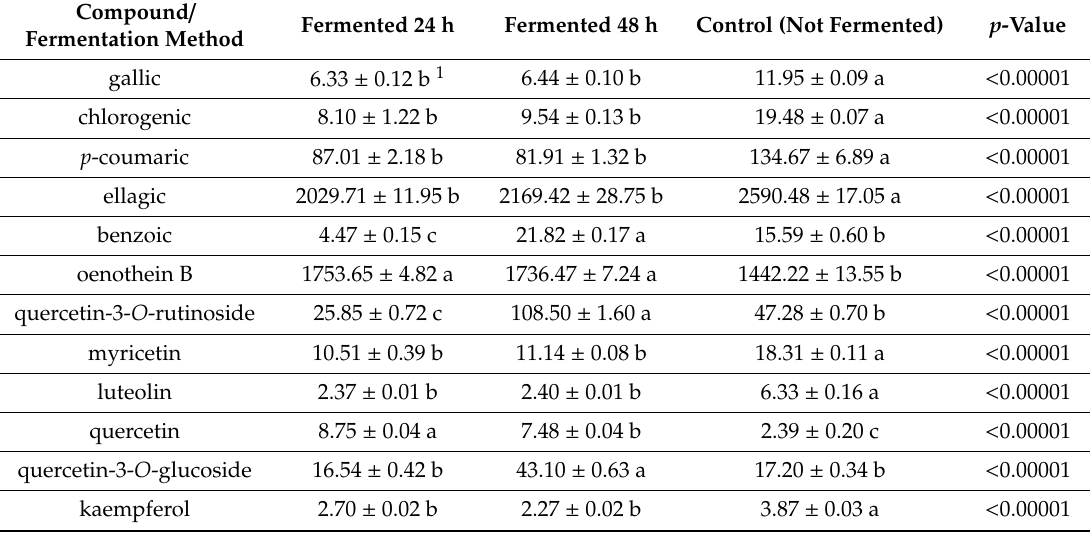
Table 3. The content of individual bioactive compounds (mg 100 g − 1 DW) in fireweed leaves in 2018. Mean value ± standard error, n =